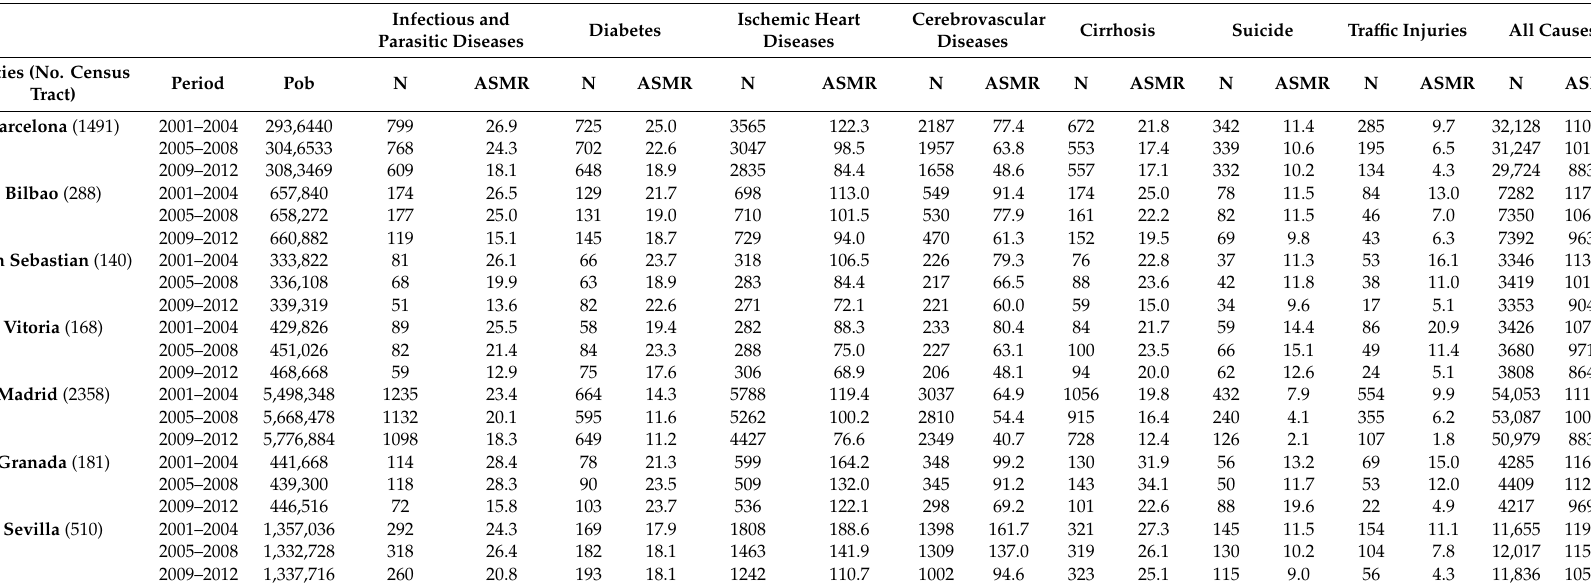
Table 1. Population, number of deaths (N), and age-standardized mortality rate (ASMR) per 100,000 inhabitants by period and cause of death in 7 Spanish cities for men, 2001–2012.